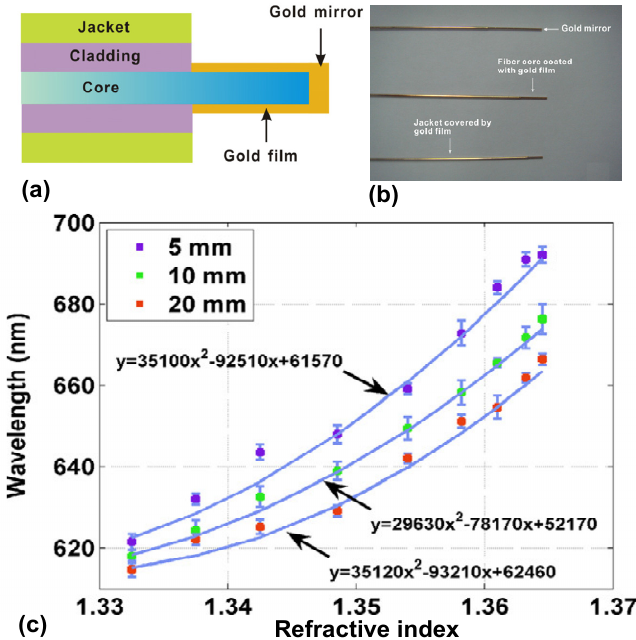
Figure 13. ( a ) Structure of a reflection type SPR fiber optic sensor; ( b ) Photo of SPR fiber optic sensors; ( c ) The resonance wavelength shift as the refractive index of the ethanol-water mixture increases in the range from 1.33 to 1.37 [112].